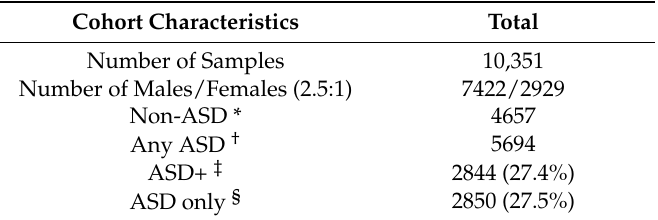
Table 1. Summary data of our neurodevelopmental patient